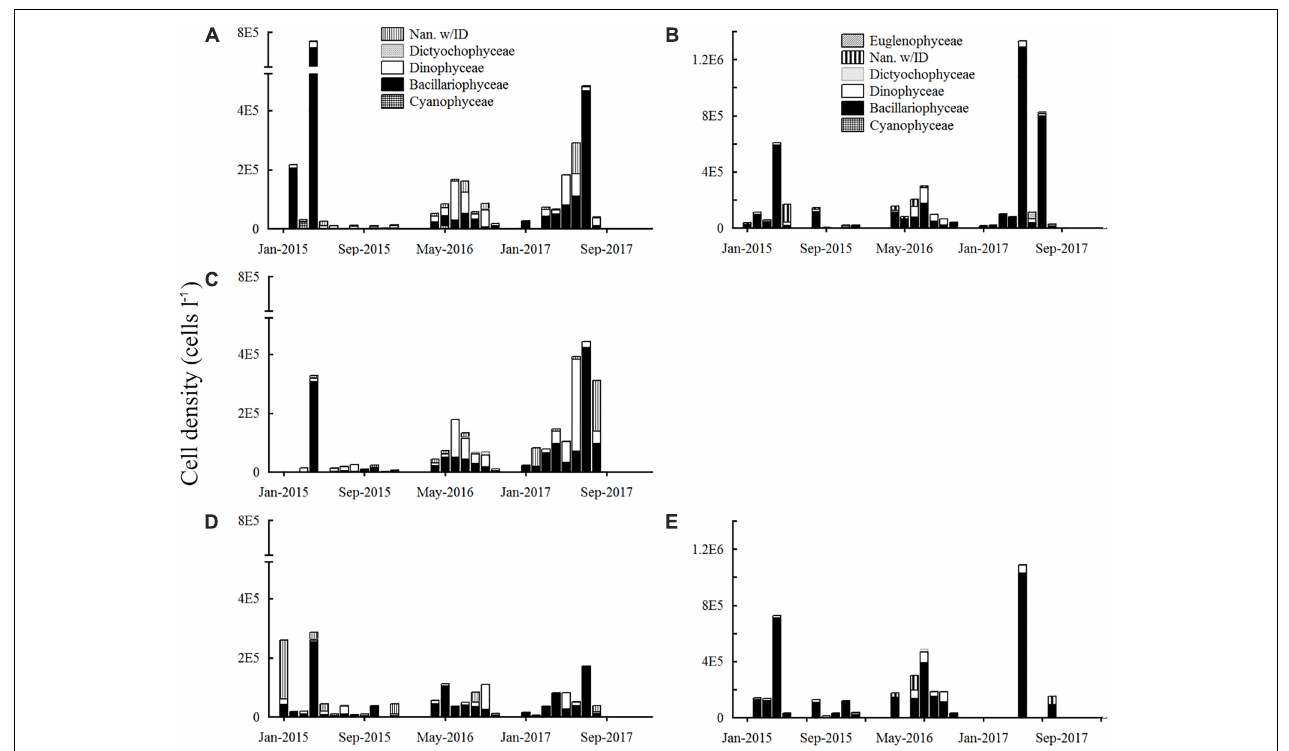
FIGURE 8 | Phytoplankton cell density in the sampling stations E6 (left column) and E9 (right column) (A) E6 surface; (B) E9 surface; (C) E6 mid-depth; (D) E6 bottom; (E) E9